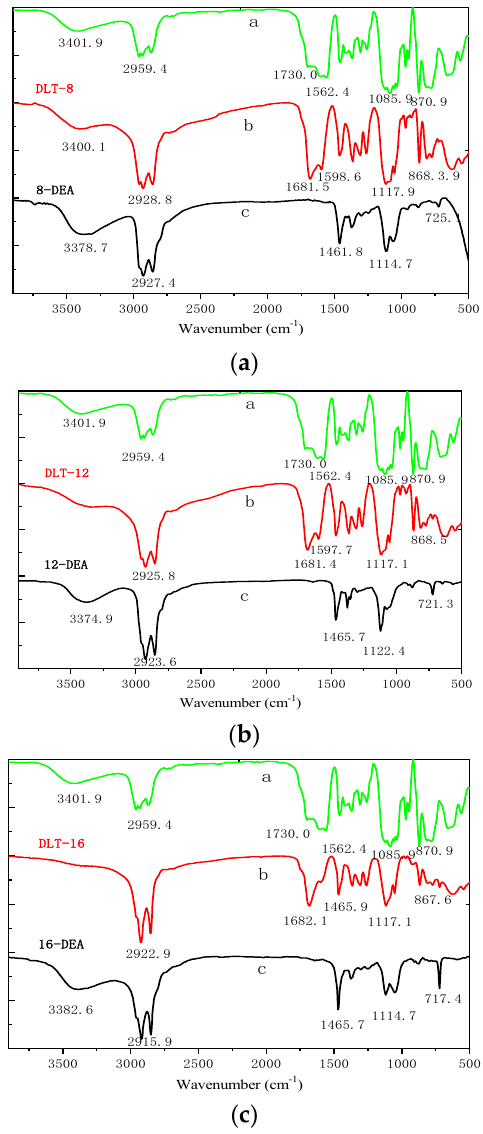
Figure 2. FTIR spectra of lactate titanate ( a ), DLT-8, DLT-12, and DLT-16 ( b ), and long chain alkyl intermediate ( c ).